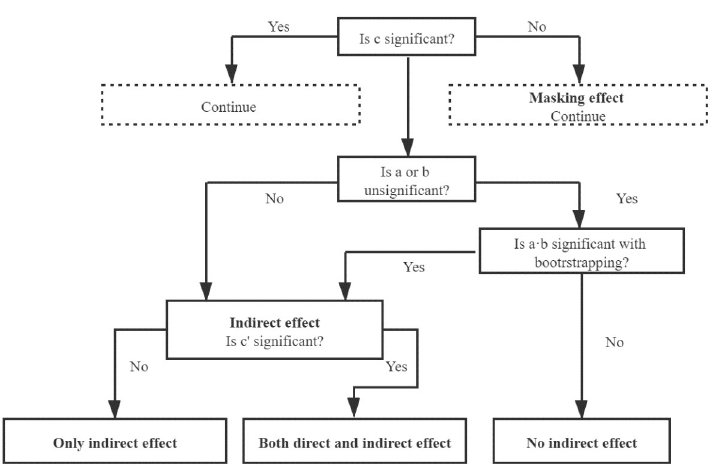
Fig 2. Test procedure of mediating effect. The 3 test procedure of mediating effect based on Eqs (4)–(6).